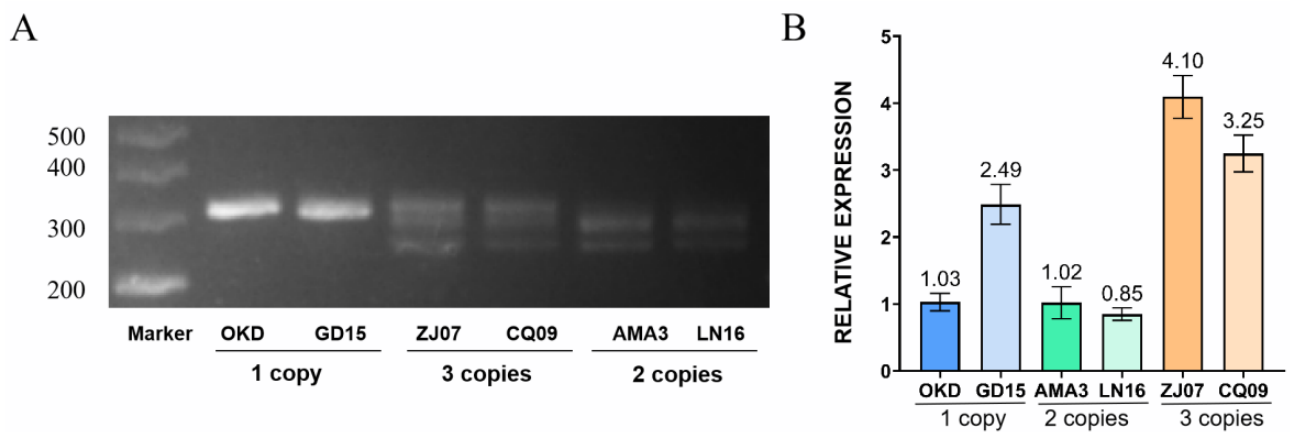
Figure 2. Gel visualization and in-vitro quantification of B. xylophilus strains with different copies. ( A ): CNV among tested strains visualized by 3% agarose gel. ( B ): Bar chart of expression level among 6 B. xylophilus using qPCR quantification.